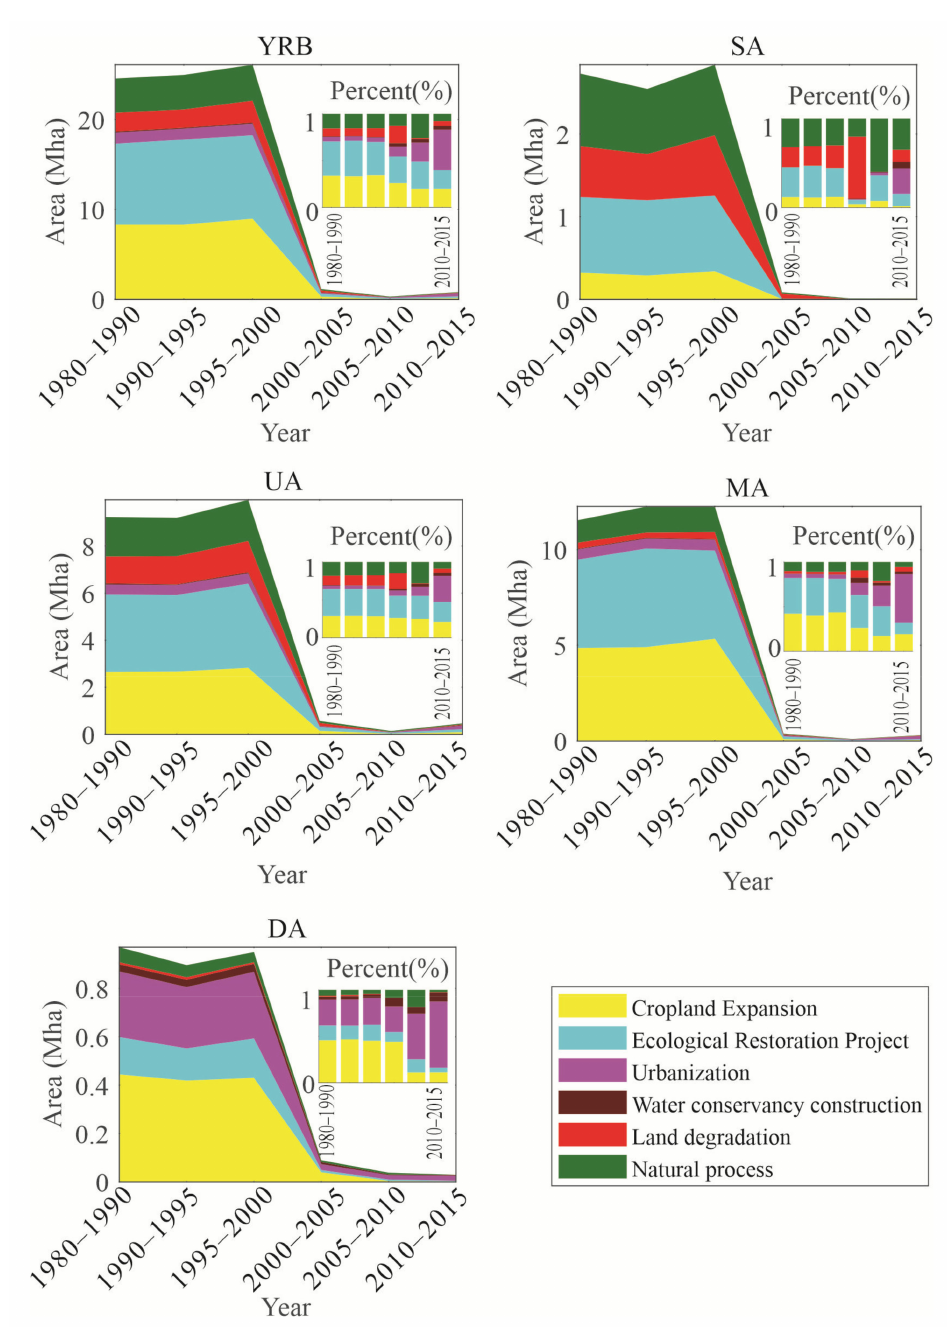
Figure 3. LULC change areas of YRB, SA, UA, MA, and DA from 1980 to 2015. The sub-figure describes the proportion of each LULC types. Cropland expansion (CE), ecological restoration projects (ERP), water conservancy construction (WCC), urbanization (UR), and land degradation (LD) are considered as human-induced LC change